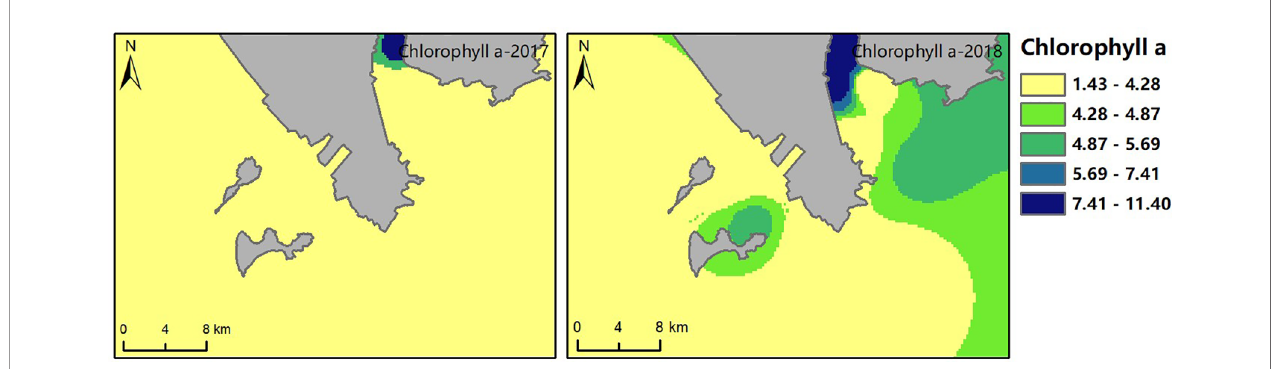
FIGURE 5 | Results of chlorophyll a in coastal of Zhuhai.